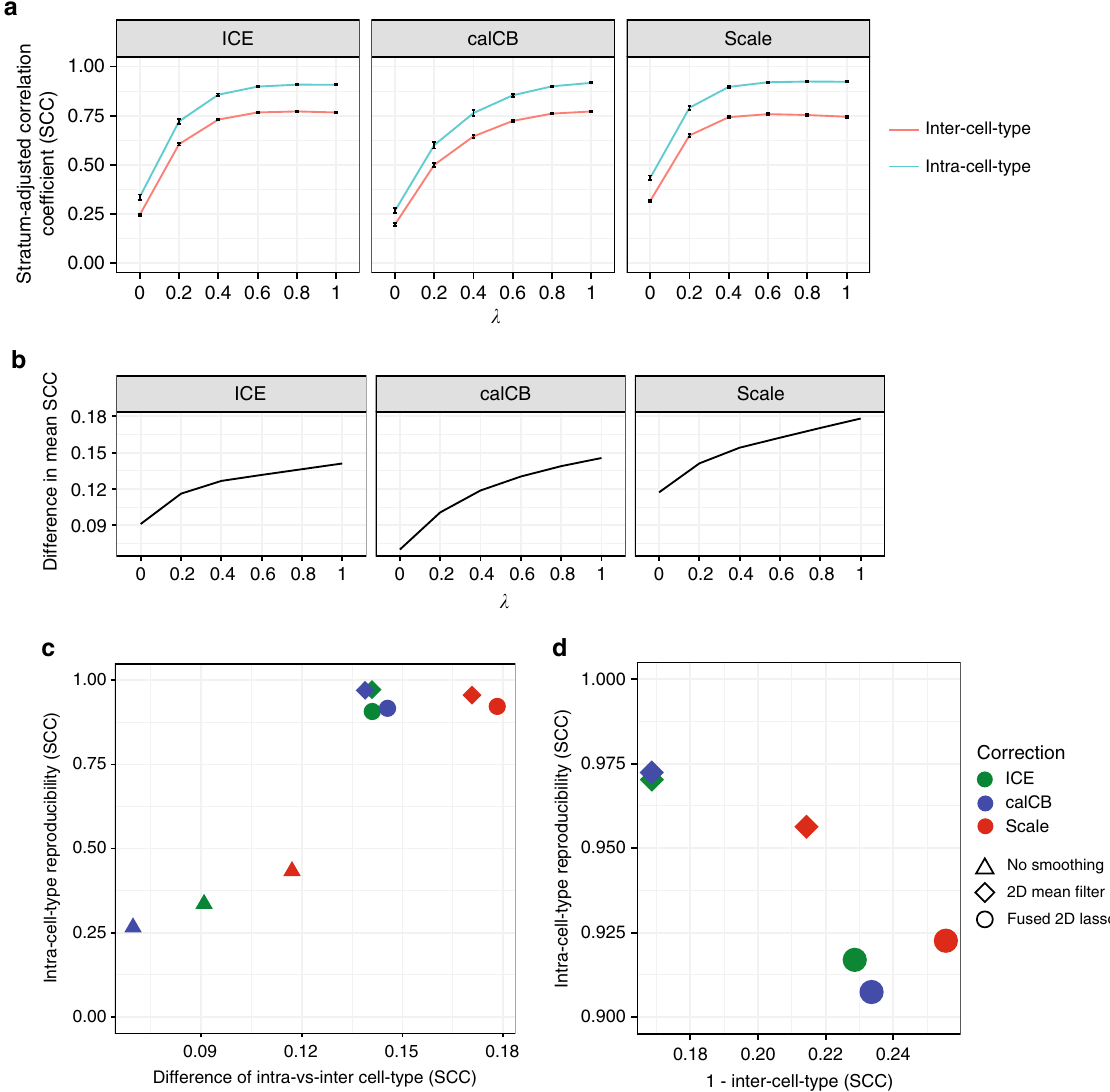
Fig. 3 Fused lasso preserves cell-type speci fi city of Hi-C contact matrices (high sequencing depth = 80 million intrachromosomal read pairs). a Effect of fused lasso on stratum-adjusted correlation coef fi cient for the case of intra-cell-type (cyan) and inter-cell-type (orange) comparisons. Matrices of 40 kb resolution were used for the analysis. The Hi-C matrices were processed with ICE, calCB, or scaling matrix correction methods. b Difference in mean stratum-adjusted correlation coef fi cient between intra-cell-type and inter-cell-type sample comparisons. c Comparison of Hi-C matrix “ correction ” and smoothing methods in terms of preservation of cell-type speci fi city ( x -axis) and intra-cell-type reproducibility ( y -axis). d Comparison of Hi-C matrix “ correction ” and smoothing methods in terms of (1 — inter-cell-type) ( x -axis) and intra-cell-type ( y -axis) stratum-adjusted correlation coef fi increase by λ (Fig. 3a), the difference between intra-cell-type and inter-cell-type correlation coef fi cients also increases (Fig. 3b), suggesting that fused 2D lasso actually preserves cell-type speci- fi city of Hi-C contact matrices, a behavior that is consistent independent of the matrix “ correction ” method. Nevertheless, combination with lasso. In addition, we also evaluated an alter- native “ smoothing ” method, 2D mean fi lter smoothing, recently made available as part of the HiCRep package 21 . In Fig. 3c, we show the results of the comparison of the three correction methods in combination with the smoothing techniques using two metrics: preservation of cell-type speci fi city ( x -axis) and intra-cell-type reproducibility ( y -axis). The main conclusions from this comparison are: (a) smoothing (lasso or mean fi lter) improves both metrics independent of the correction method, and (b) fused lasso performs slightly better than mean fi lter